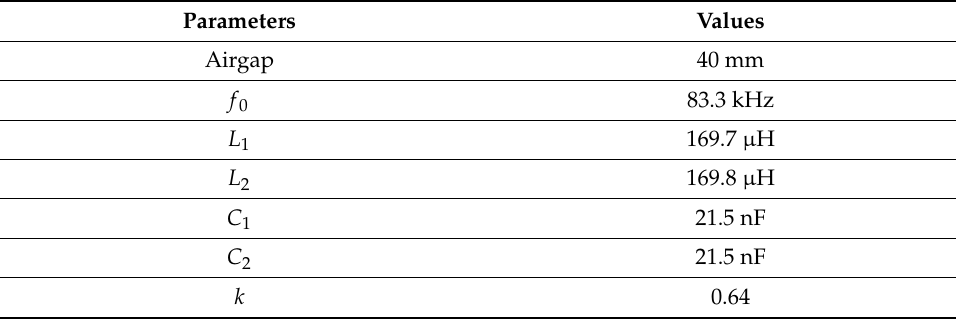
Figure 7. Photo of the experimental prototype. Table 1. Parameters of experimental prototype.